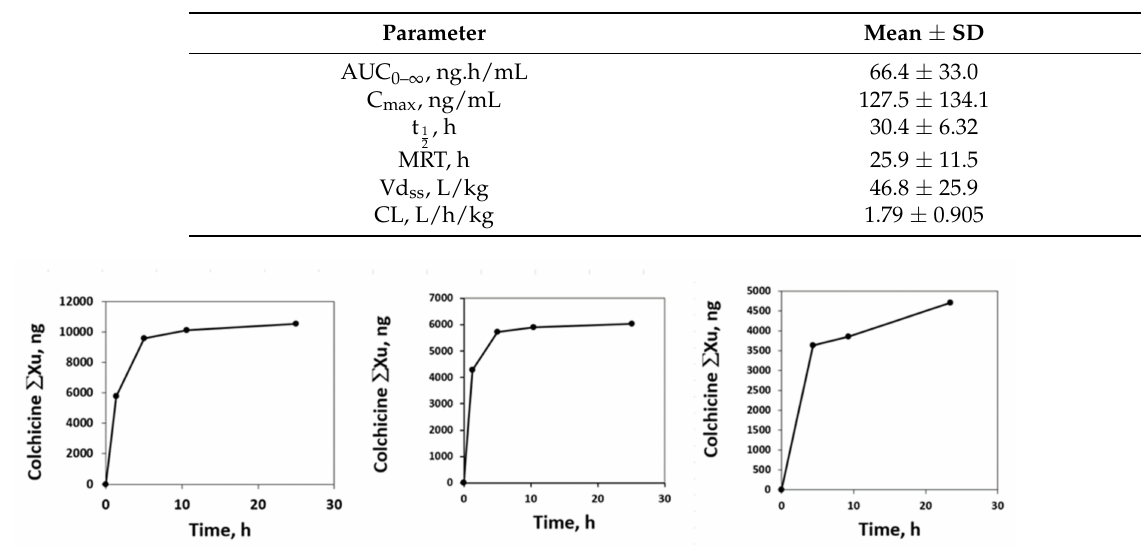
Figure 6. Blood concentration vs. time profiles of colchicine given intravenously at a dose of 0.1 mg/kg to three male Sprague-Dawley rats. The blood volumes assayed ranged from 0.1 to 0.25 mL. Table 4. Colchicine pharmacokinetic data summary from three male Sprague-Dawley rats.